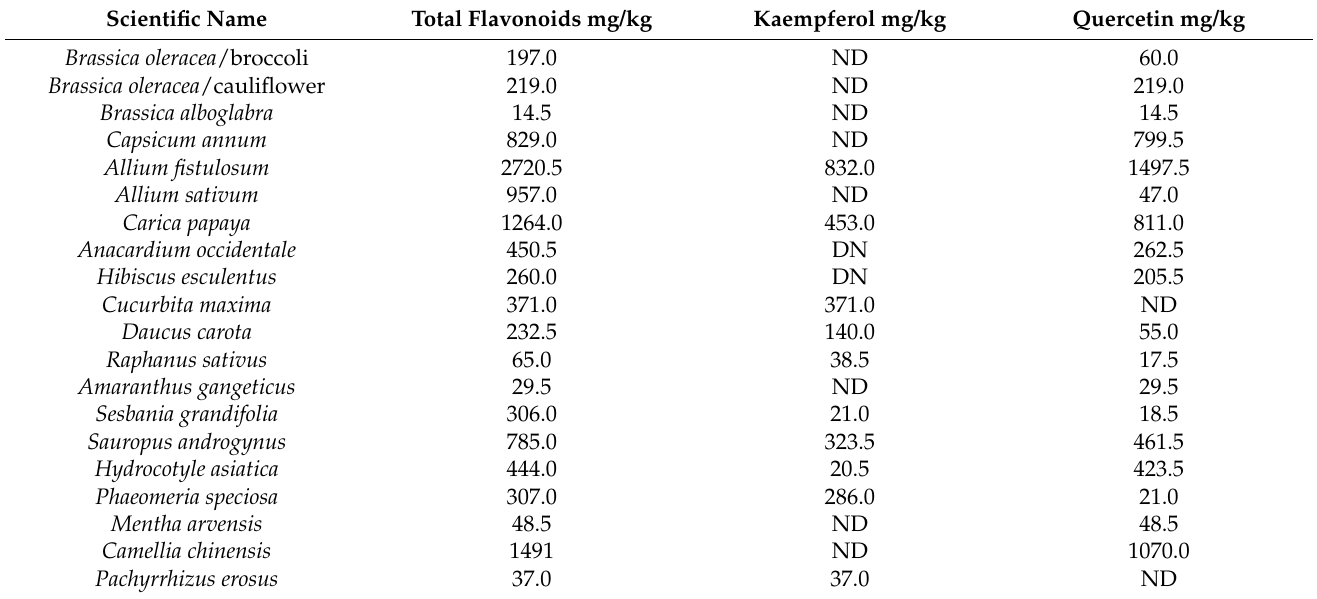
Table 1. Total flavonoids, kaempferol and quercetin in selected edible